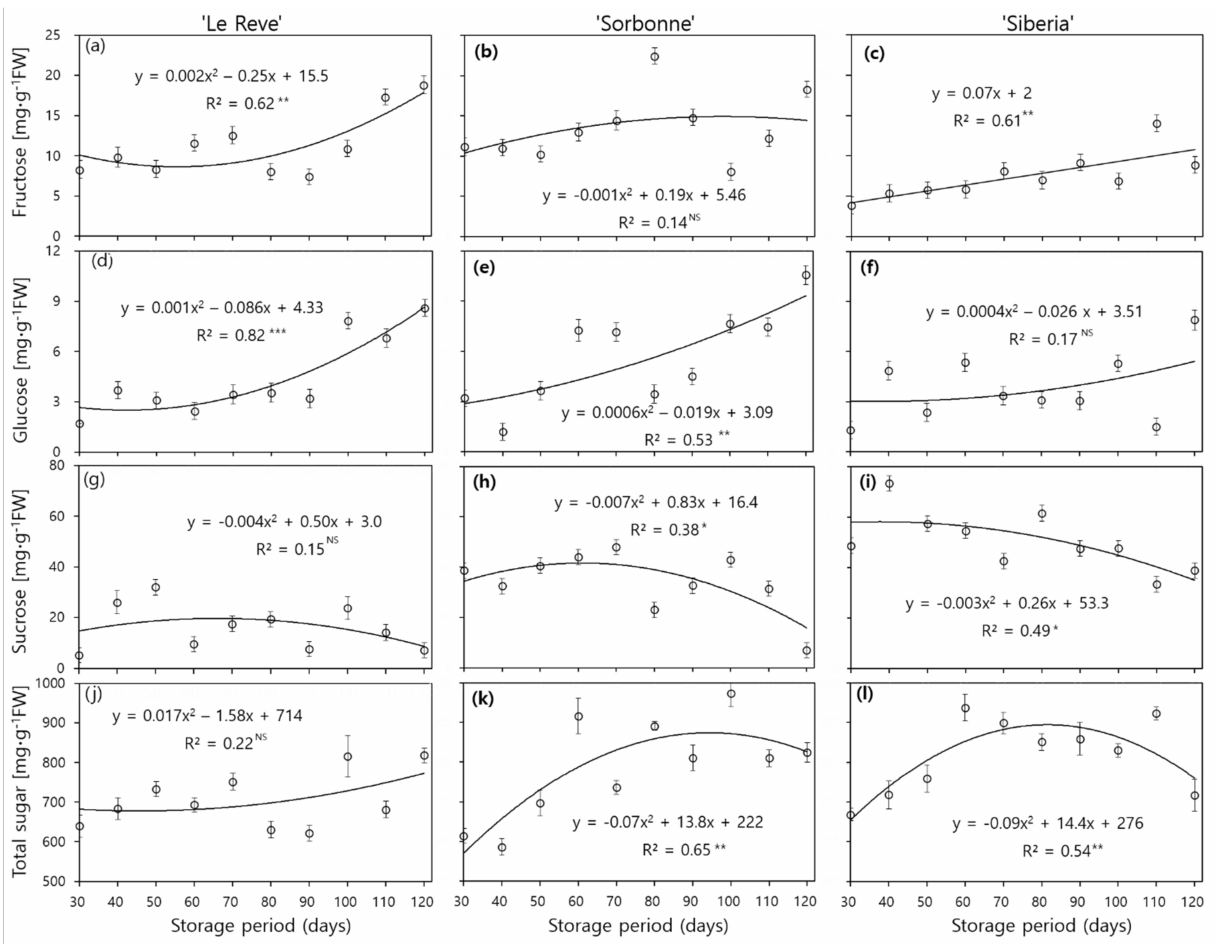
Figure 2. Contents of three soluble sugars and total sugar in bulbs measured at the end of each bulb storage periods at 0 ◦ C in Lilium Oriental Hybrids ‘Le Reve’ ( a , d , g , j ), ‘Sorbonne’ ( b , e , h , k ), and ‘Siberia’ ( c , f , i , l ). NS, *, **, *** Non-significant or significant at p < 0.05, 0.01, or 0.001,